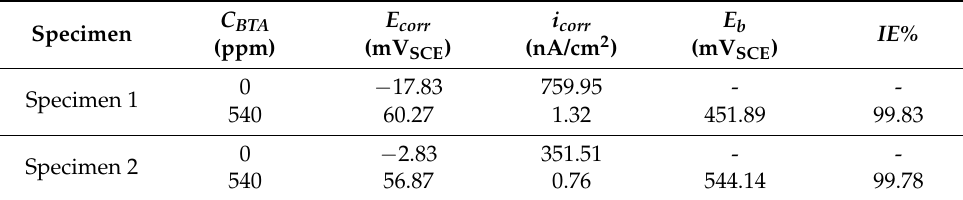
Table 4. Electrochemical parameters from polarization measurements on specimen 1 and specimen 2 in synthetic tap water at 25 ◦ C based on the presence and absence of